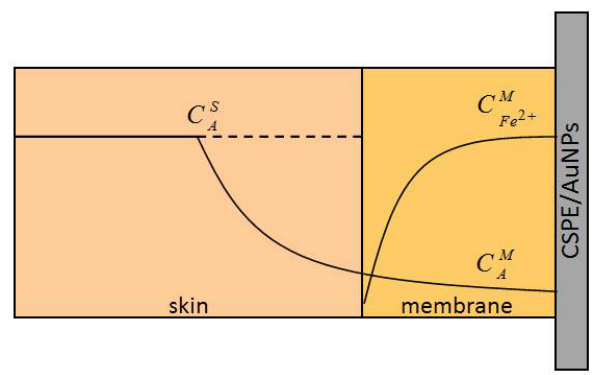
: the concentration A